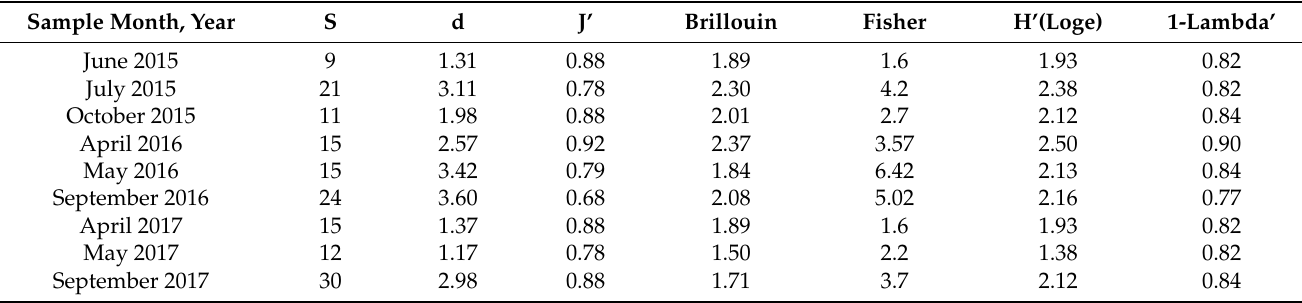
Table 3. Diversity index assessments for ichthyoplankton sampling at field sites in the outer Ther- maikos Gulf of the Aegean Sea offshore of the coastal zone of Kitros, in the Pieria region of Greece. The number of species (S) is given, and results are presented for the abundance index Margalef (d), the Brillouin index, Fisher’s statistical parameter a , Pielou’s normality index (J), the diversity index of Shannon-Wiener (H ´ ), and the Simpson’s diversity index